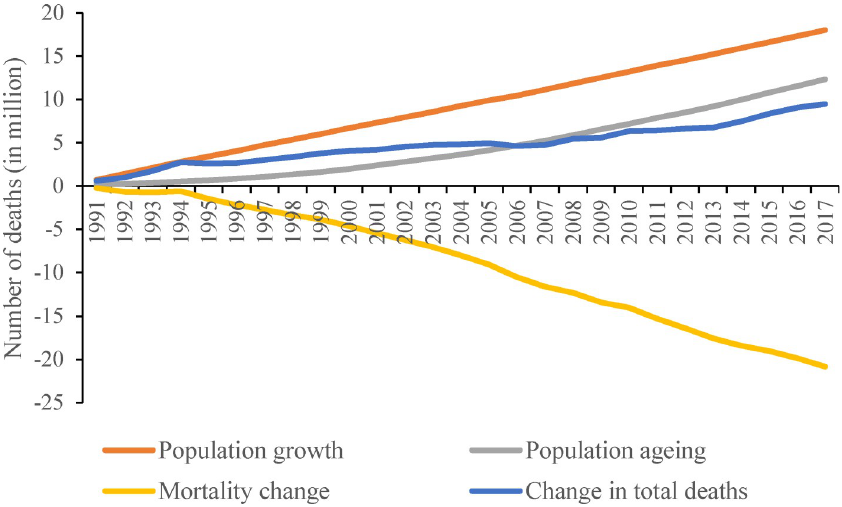
Fig 1. Global death changes associated with population ageing, population growth, and mortality change from 1990 to 2017. The decomposition was conducted using the number of deaths in 1990 as the reference for each year.